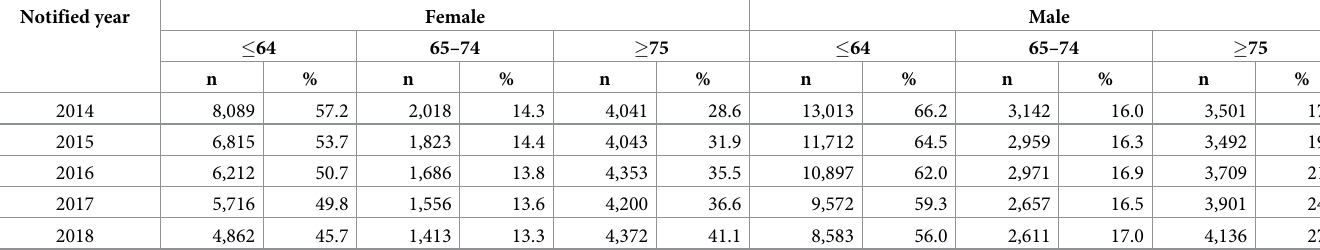
Table 1. All registered patients with tuberculosis by year, age group, and gender. Notified year